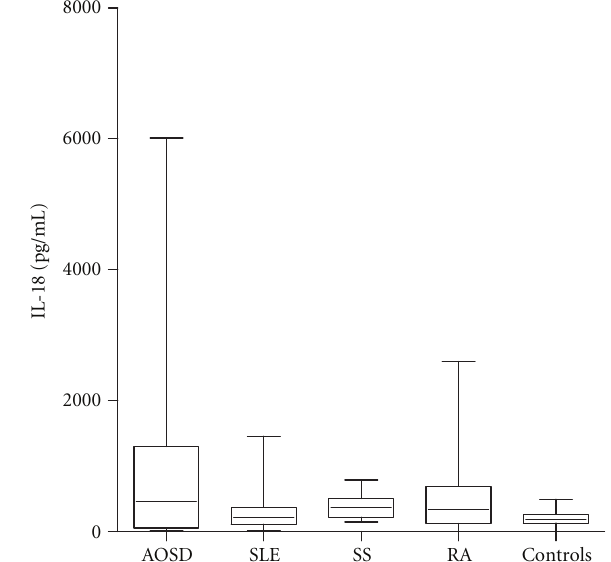
Figure 2: Box-and-whisker plot of IL-18 serum levels in patients with AOSD ( n = 26), RA ( n = 21) SS ( n = 21), SLE ( n = 20), and NHS ( n = 21). Median, quartiles, range, and possibly extreme values are